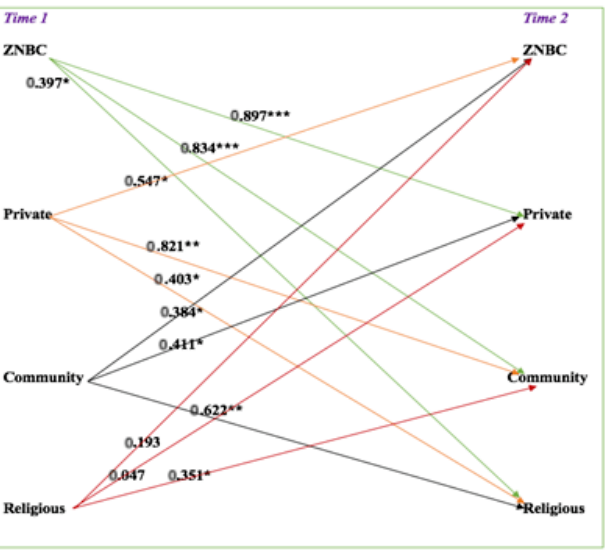
Figure 1. Cross-lagged correlations comparing the issue agenda of ZNBC and the Zambian media. Note: * p < 0.05; ** p < 0.01; *** p <